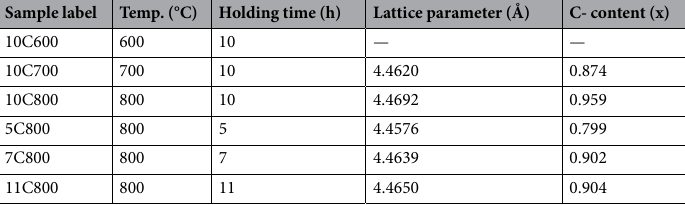
Sample label Temp. (°C) Holding time (h) Lattice parameter (Å) C- content (x) — —